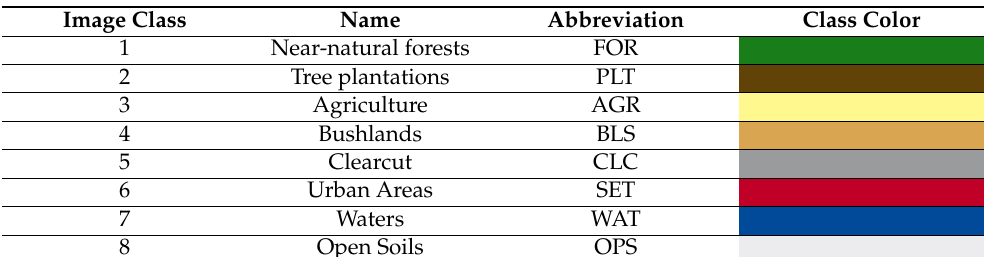
Table 1. Main classes, abbreviations, and class colors used in classification. For a list of subclasses and class agglomeration, see Appendices B and